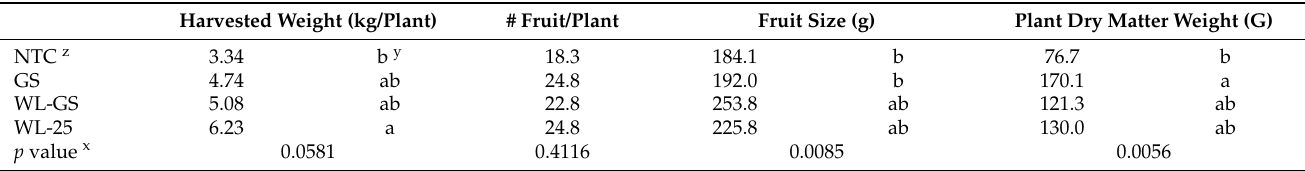
Table 7. Tomato yield, fruit size, and plant dry matter weight. All red fruit were counted, and harvest-weighed collectively weekly. Fruit weight was collected from random sample of five ripe fruit per replicate on final harvest date. Plant dry matter weight was collected from plants after removal of all fruit at final harvest.